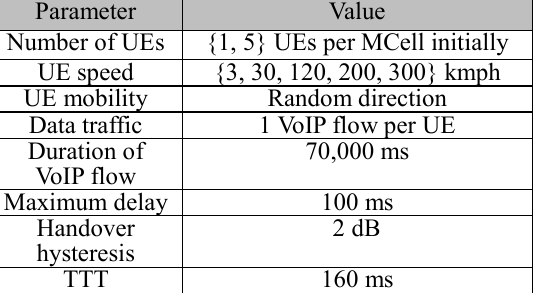
Table 3. The parameters of the traffic.